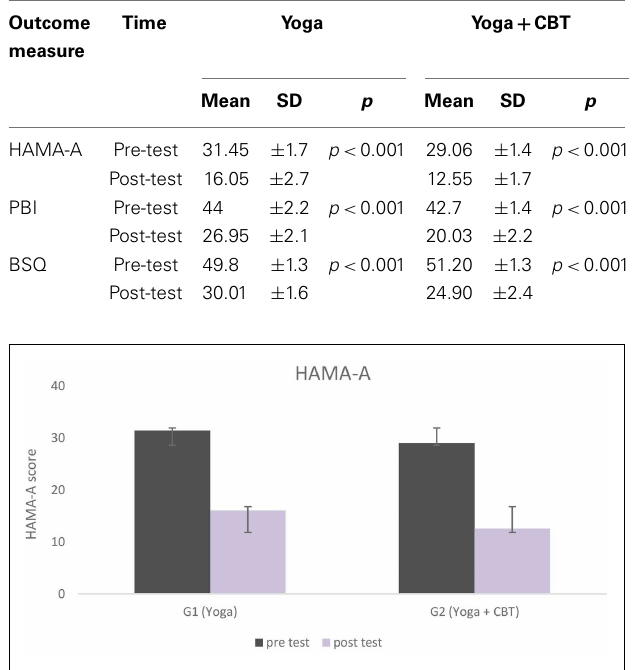
Table 2 | Means and SD of the psychological parameters’ scores for both treatment groups at each assessment point .